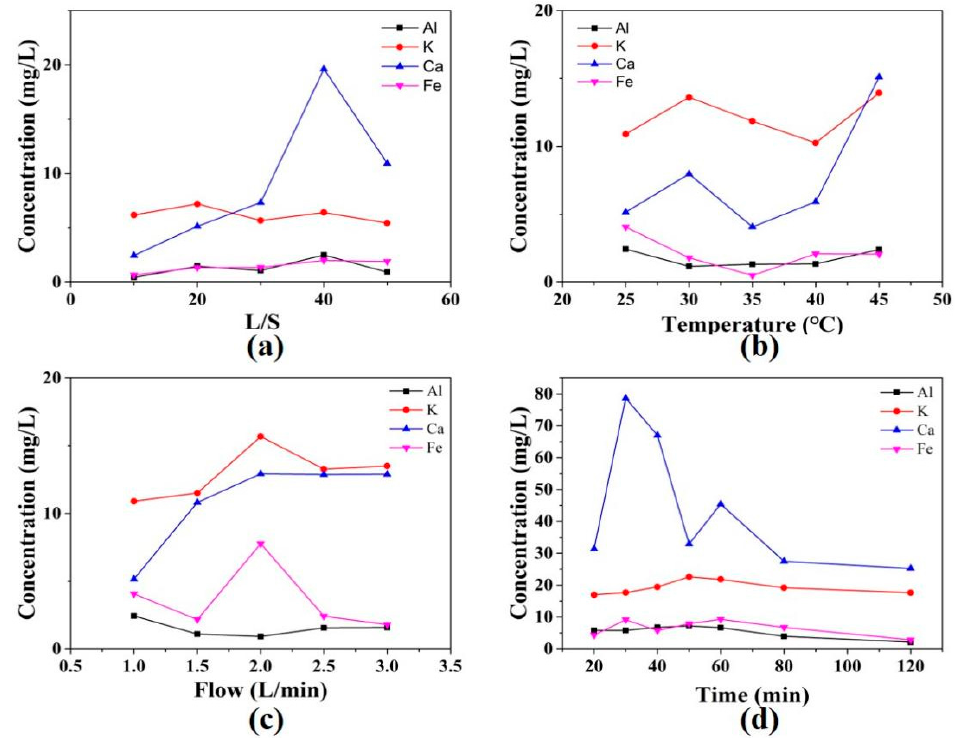
Figure 3. Effect of L/S ( a ) temperature ( b ) flow rate ( c ) time ( d ) on the concentration of impurities [liquid-solid ratio = 20, temperature = 25 °C, flow rate of CO 2 = 3 L/min].